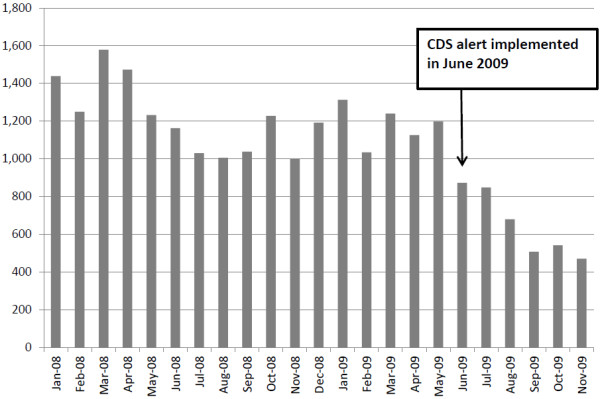
Number of monthly inpatient BNP tests, January 2008 – November, 2009.